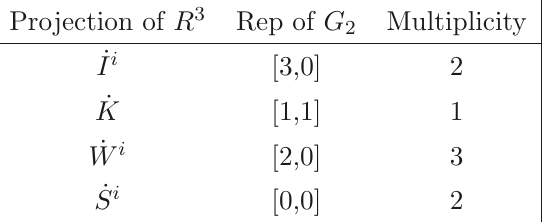
Table 4 . Valid embeddings of